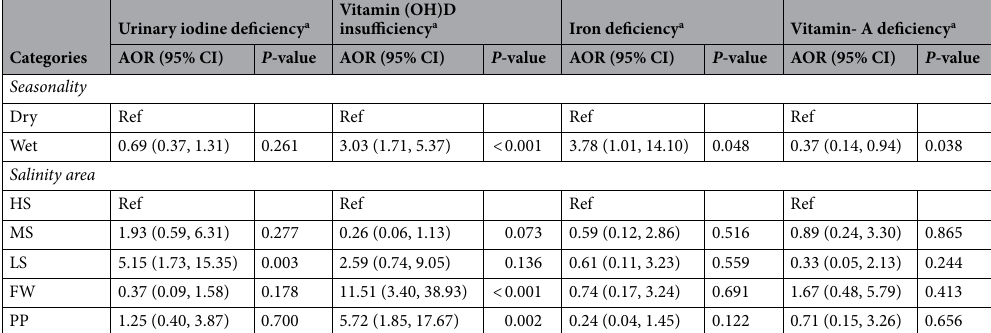
Table 3. Risk factors for urinary iodine, serum vitamin (OH)D, iron and vitamin A deficiencies among the adolescent girls. AOR adjusted odds ratio, pp percentage point, CI Confidence Interval, Ref . Reference. a Adjusted for each other and other variables (age, BMI, dietary diversity score, and wealth quintiles). Adjusted odds ratios were estimated using mixed effect logistic regression where independent variables were the seasonality and agro-aquatic region.